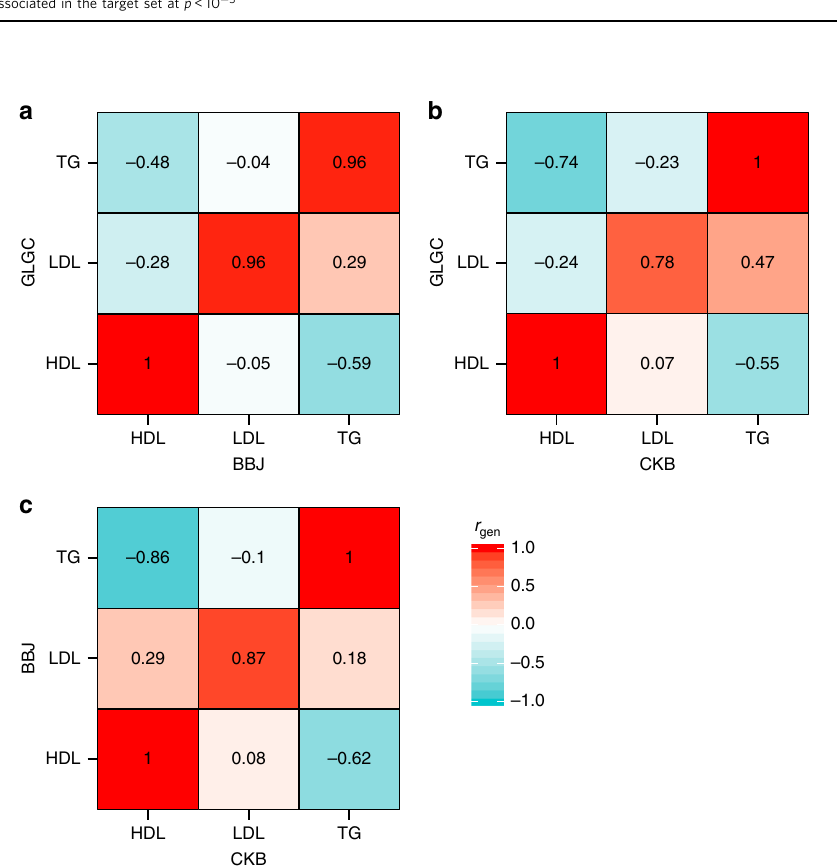
Fig. 1 Trans-ethnic genetic correlations r gen for associations with high-density lipoprotein (HDL), low-density lipoprotein (LDL) cholesterol and triglycerides (TG). a shows the comparison of GLGC2013 (European) and Biobank Japan (BBJ), b GLGC2013 and China Kadoorie Biobank (CKB) and c BBJ and CKB. The values on the diagonal show correlations for matched lipid markers in the two studies. The off-diagonal values show genetic correlations across lipid biomarkers (e.g. HDL vs TG). Colours correspond to the direction and strength of r gen